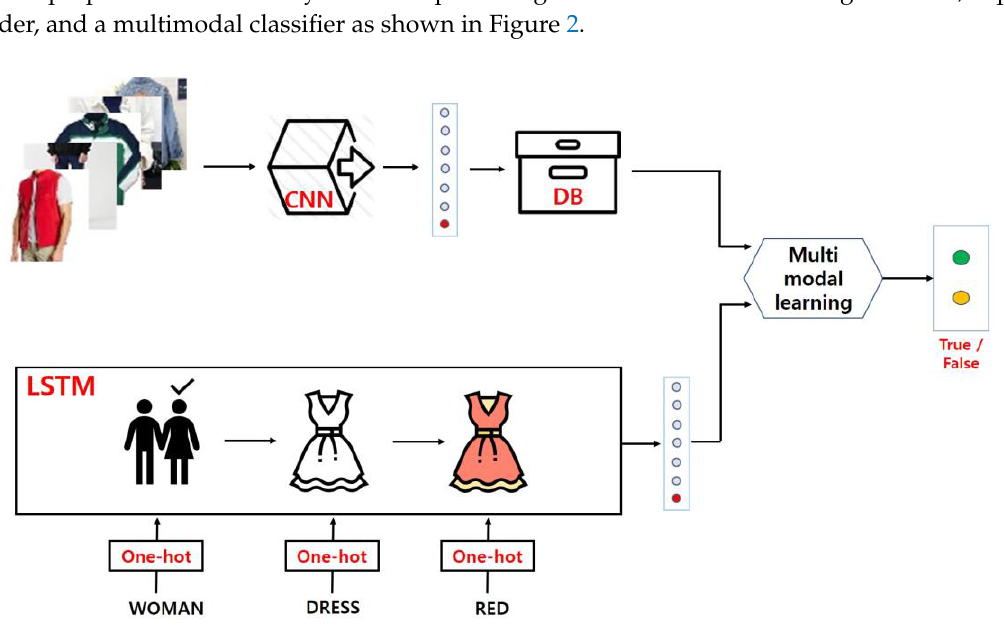
Figure 2. Proposed deep learning network for efficient fashion product retrieval. Feature vectors of product images created by the deep CNN and query vectors generated by LSTM-based one-hot encoding are then combined together to semantically train the model with fashion products and classify them.